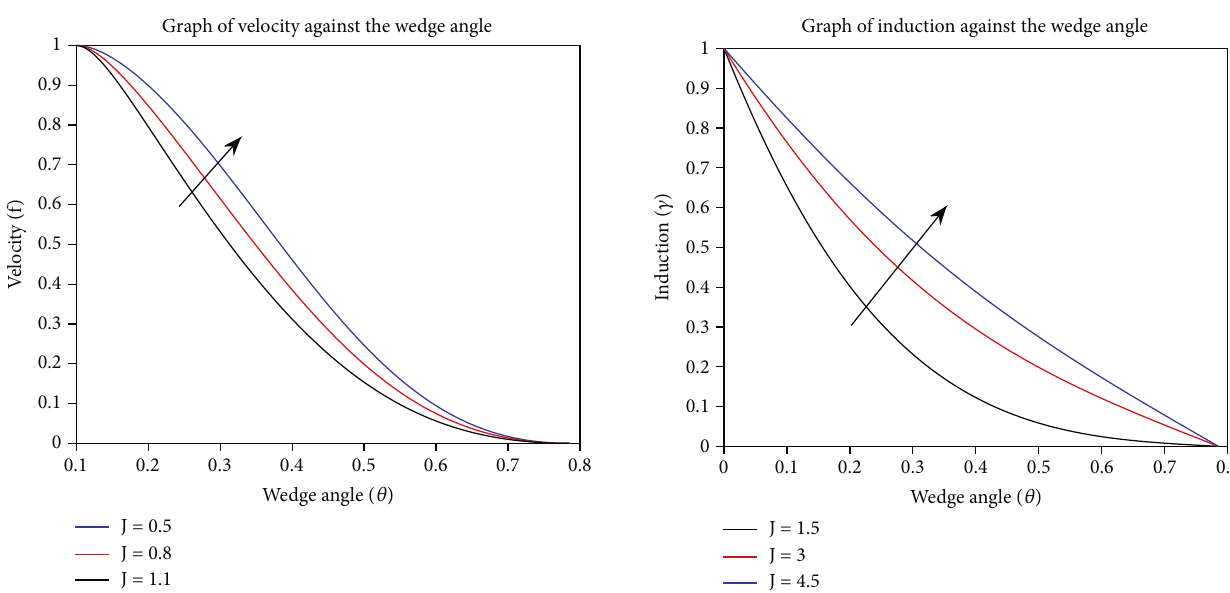
Figure 13: E ff ect of varying the Joule heating parameter on magnetic induction.